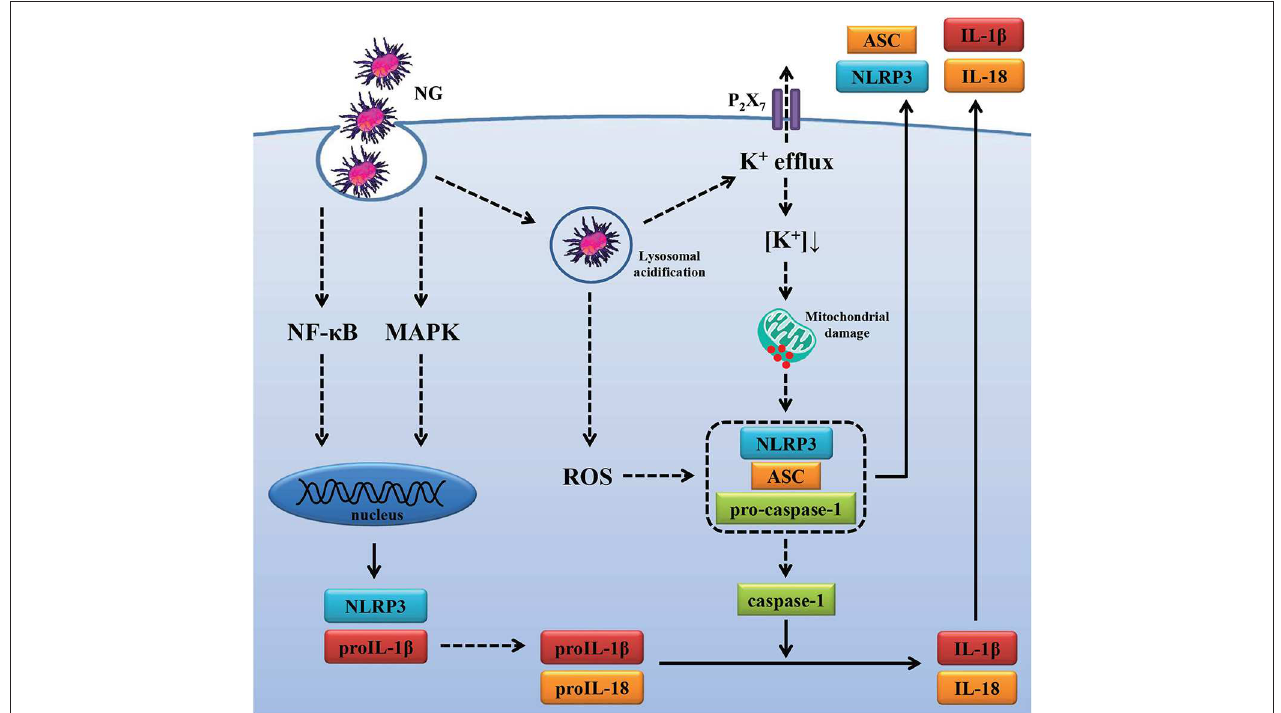
FIGURE 10 | Overview of the putative mechanisms by which NG activated the NLRP3 inflammasome. NG activated the NLRP3 inflammasome in macrophages through (1) increasing NLRP3 and proIL-1 β expression by activating NF- κ B and MAPK; (2) increasing caspase-1 activation and IL-1 β /IL-18 secretion by ROS production, lysosomal acidification, P 2 X 7 receptor-mediated K + efflux and mitochondrial damage.